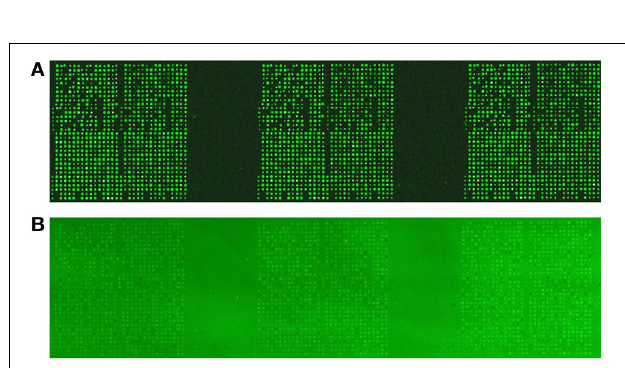
FIGURE 2 | Printing and validation of the bee-specific peptide array. (A) The arrays were printed by a commercial provider (JPT Peptide Technologies, Berlin, Germany). For each array, each spot was printed in triplicate within each block. Each block was then printed in triplicate, for a total of nine technical replicates of each peptide. This image, taken as a quality control step in array production, illustrates the consistency and reproducibility of peptide spotting. (B) An image of a data scan of a representative array used for analysis of a whole-bee sample. A clear and consistent pattern of peptide phosphorylation is apparent across the three printed